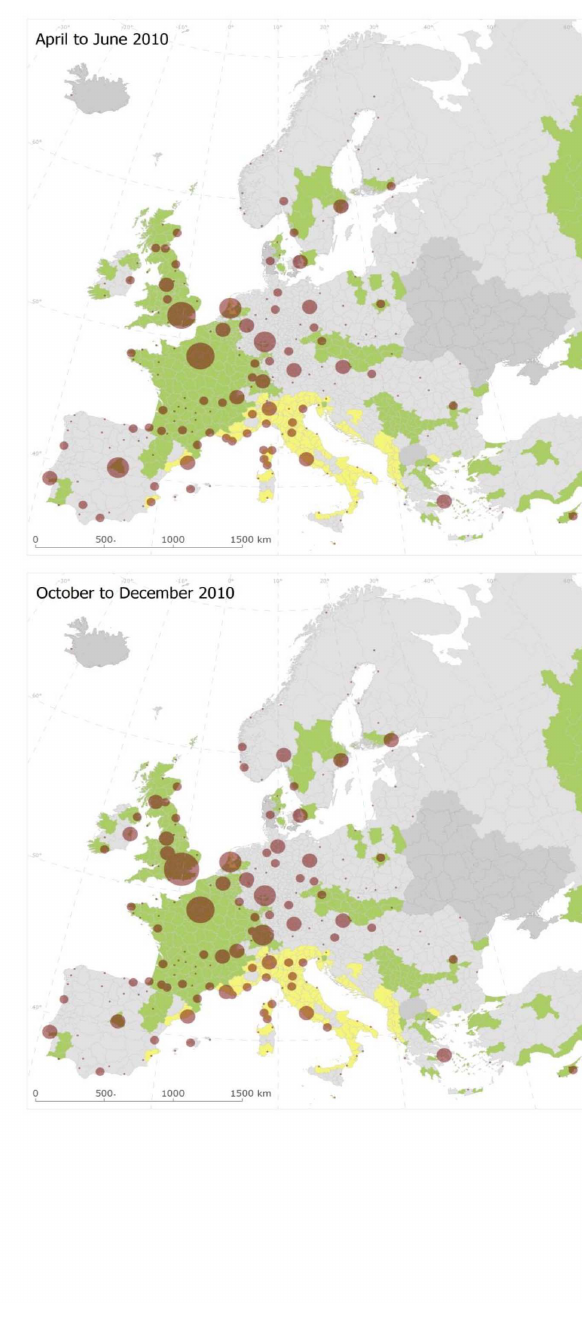
Figure 5. Airport-level final destination of international travellers from dengue affected areas (endemic and epidemic) by quarter for 2010, overlaid with the presence of Ae.albopictus , 2010.